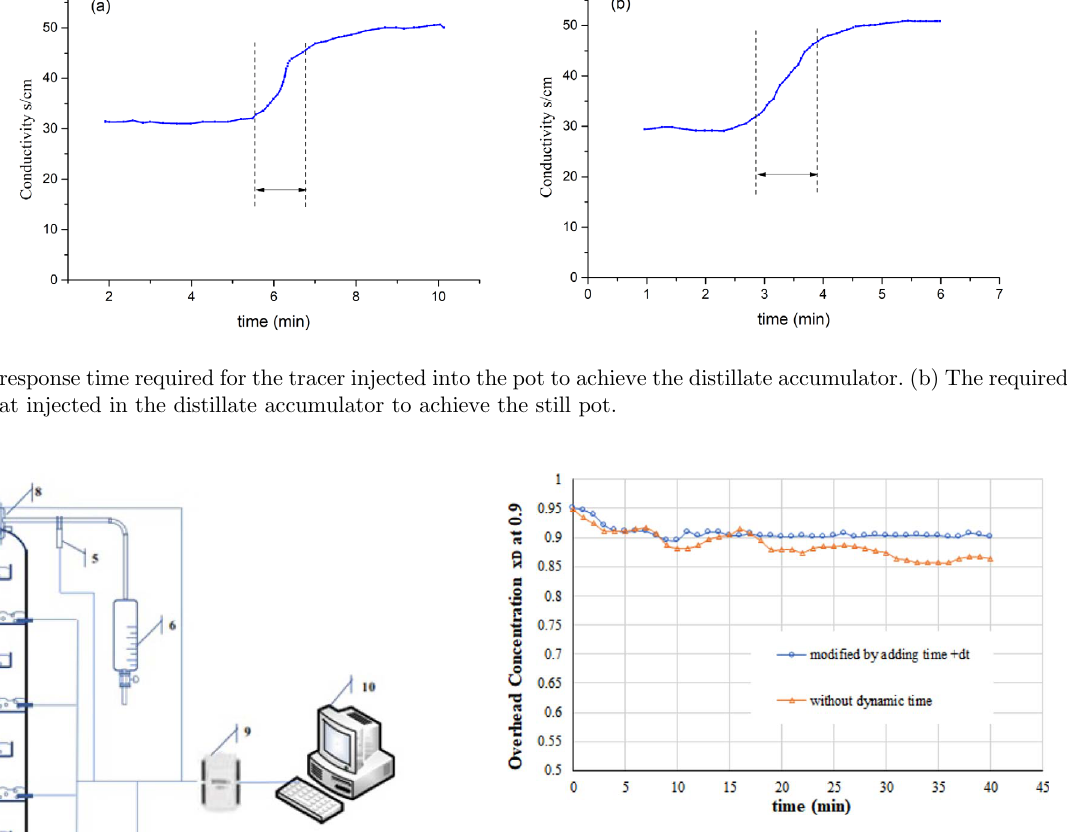
Fig. 5. Overhead concentration at setup points at 0.9 with/ without adding dynamic-time (+ dt